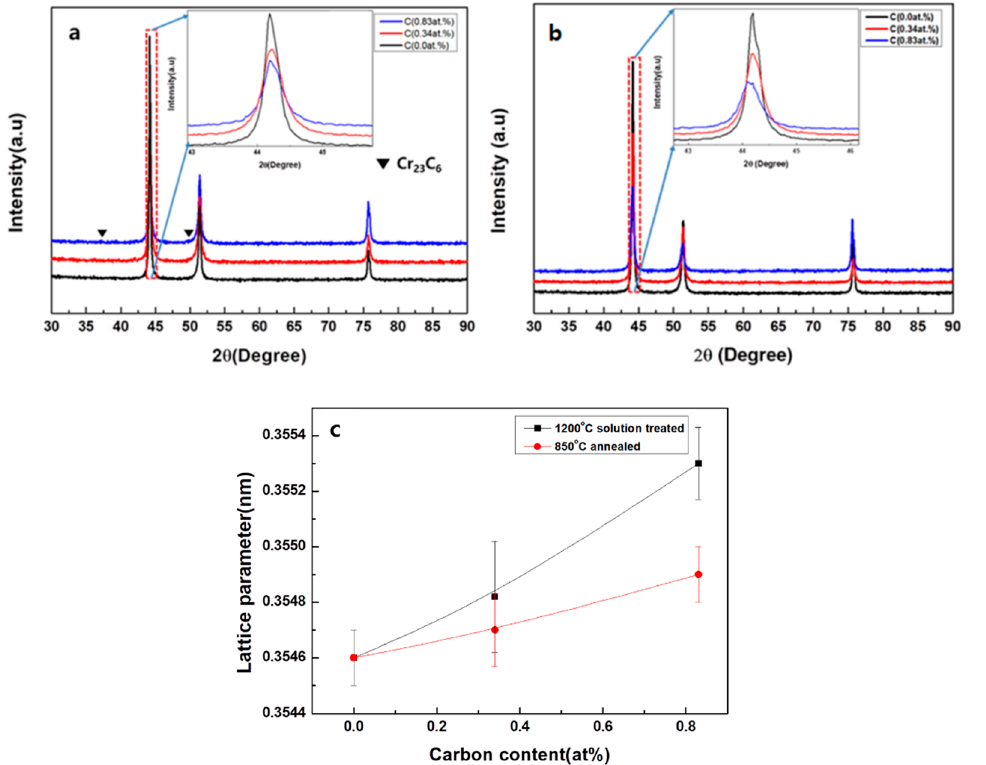
Figure 1. X-ray diffraction (XRD) spectra from the solid solution treated (at 1200 °C) ( a ) and annealed (at 850 °C) alloys. ( b ) and the variations of lattice parameters of both alloys ( c